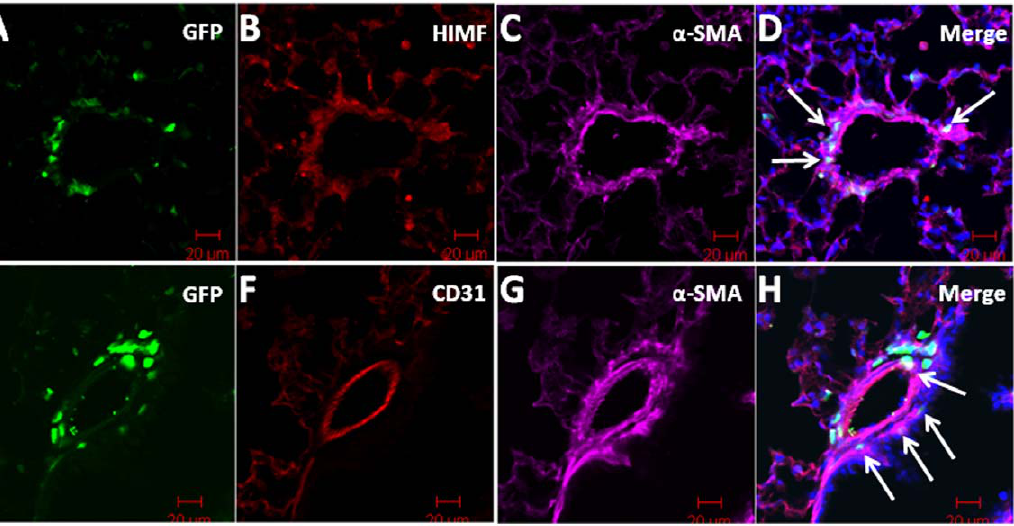
Figure 6. GFP + cells were recruited to the smooth muscle layer of the pulmonary vasculature in AAV-HIMF-treated mice. GFP was detected through direct visualization (A, E; green). HIMF and a -smooth muscle actin ( a -SMA) were detected with anti-HIMF and anti- a -SMA primary antibodies and visualized with rhodamine-conjugated anti-rabbit IgG secondary antibodies (B; red) and Cy5-conjugated anti-mouse IgG secondary antibodies (C; pink), respectively. Arrows in the merged image indicate co-localization of GFP, HIMF, and a -SMA (D). Lung sections were stained with anti-CD31 antibodies and visualized with rhodamine-conjugated anti-rat IgG antibodies (F; red) and anti- a -SMA antibodies and visualized with Cy5-conjugated anti-mouse IgG antibodies (G,pink). (F) Arrowsinthemergedimageindicateco-localizationofGFPand a -SMA.Cellnuclei werestainedwithDAPI(D, H; blue) Scalebar: 20 m m.